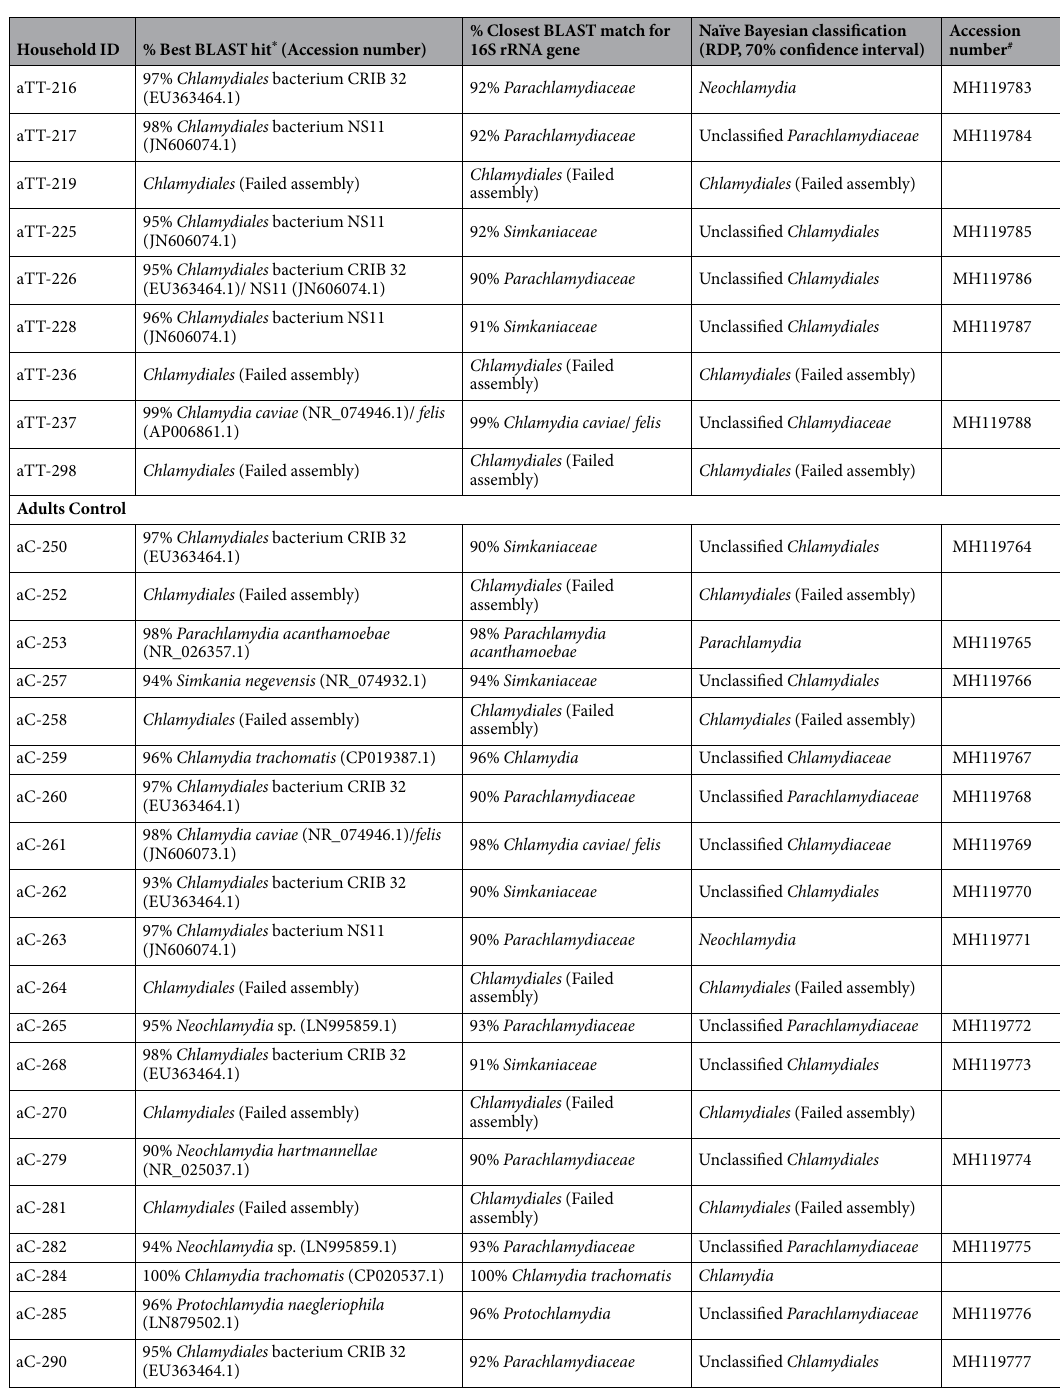
Table 2. BLAST-n analysis and RDP classification of Chlamydiae 16 S rRNA sequences detected in ocular swabs of children and adults. * Uncultured bacteria were excluded from final BLAST hits by choosing the “Exclude” option in BLAST-n page for “Uncultured/environmental sample sequences”. # Accession numbers for submitted sequences to the NCBI database (https://www.ncbi.nlm.nih.gov/genbank/). § GenBank accession number was not provided for the cTF-092 because the BLAST query coverage was less than 90% to other Chlamydiales 16S